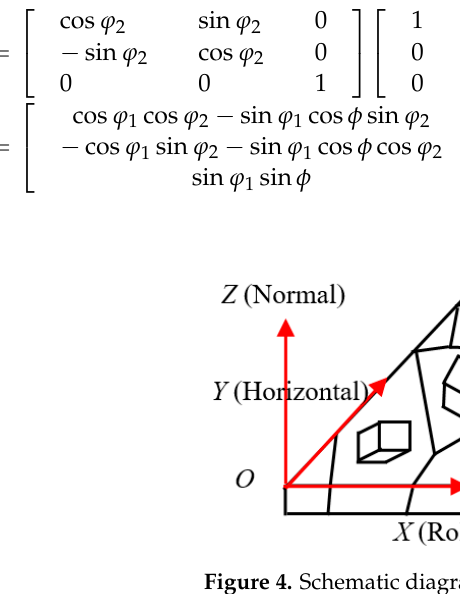
Figure 4. Schematic diagram of general grain orientation inside polycrystalline materials.